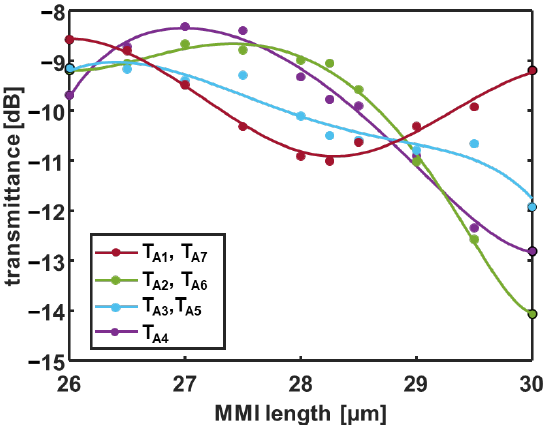
Figure 7. Transmittances T Ai at the output ports in dB as a function of the MMI length (calculated values (dots) and polynomial fitting (solid curves)) at the wavelength λ = 1.55 µ m. The same multilayer of the OWS is considered in the FDTD simulations with the UV26 cladding thickness t = 1 μm.